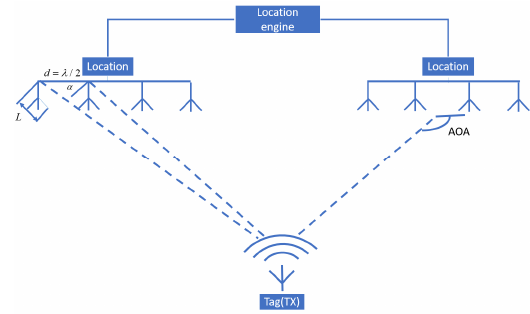
Figure 4. Bluetooth positioning diagram